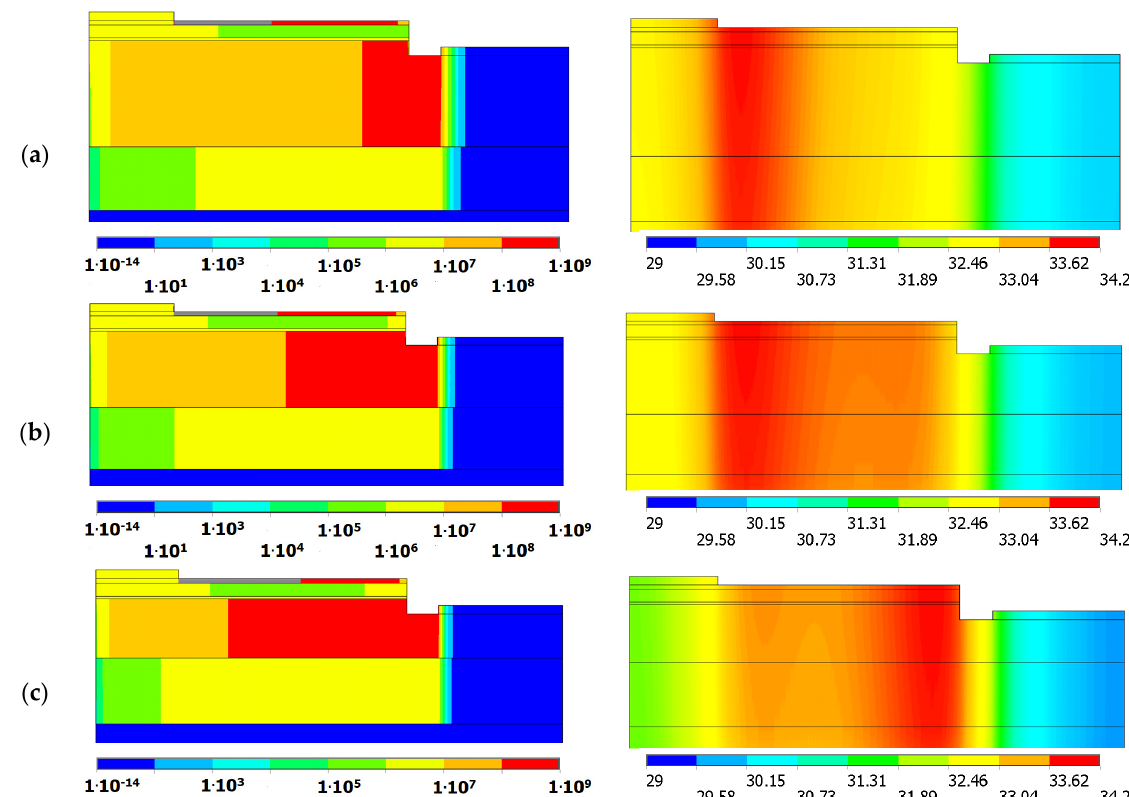
Figure 11. Results illustrating the influence of the thickness of the n-GaN:Si layer. Current density ( left ) and temperature ( right ) distributions within the modified modelled structure for a forward bias of: ( a ) 3.62 V (d = 2.15 µm), ( b ) 3.78 V (d = 1.5 µm), and ( c ) 4.13 V (d = 1.0 µm).